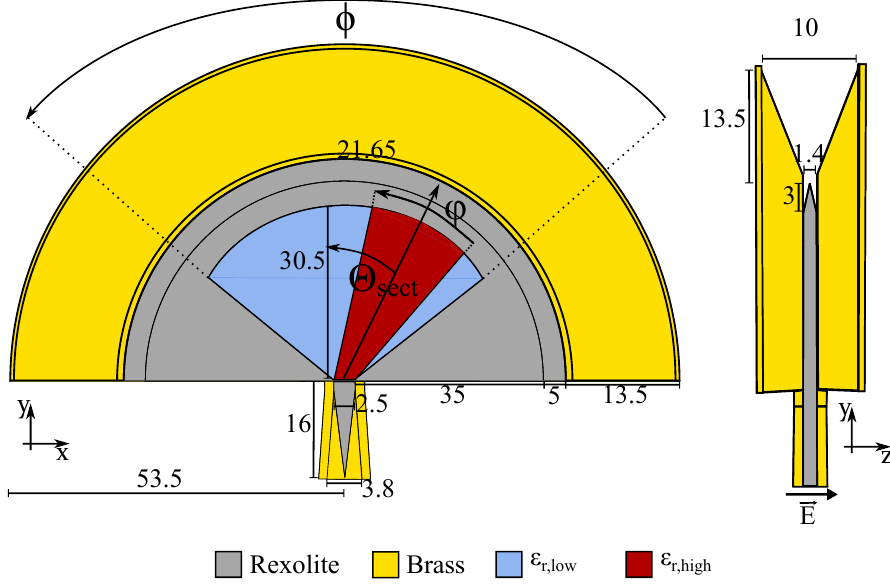
Figure 40. Representation of the lateral wave beam steering antenna in parallel plate topology. Lengths are in mm.